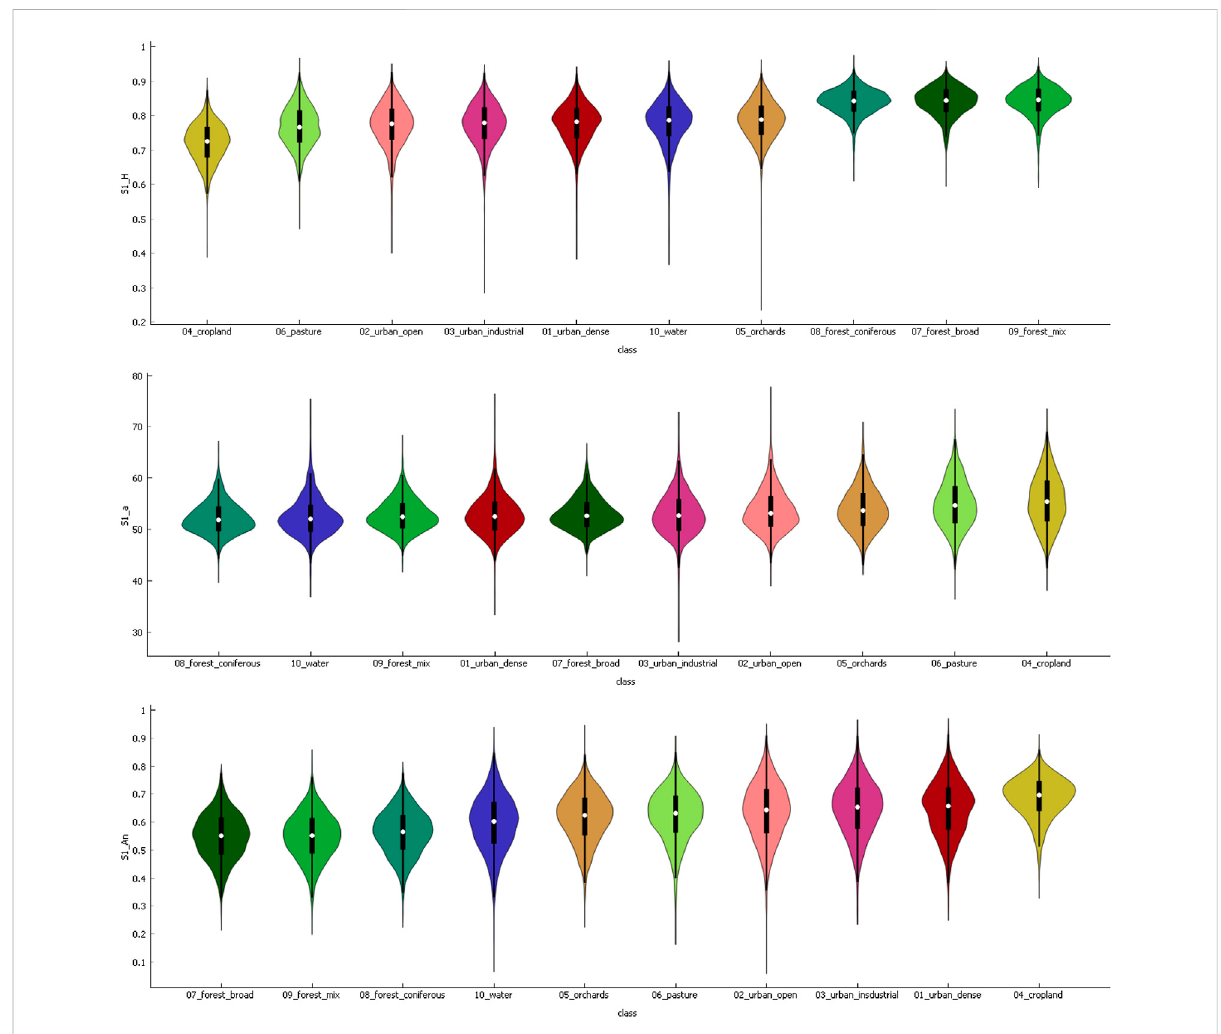
FIGURE 7 Violin plots of Entropy (top), Alpha (middle) and Anisotropy (bottom) for the ten land use and land cover classes. Colors assigned as in Figure 3. Black bars cover the interquartile range (middle 50%) and the white marker indicates the